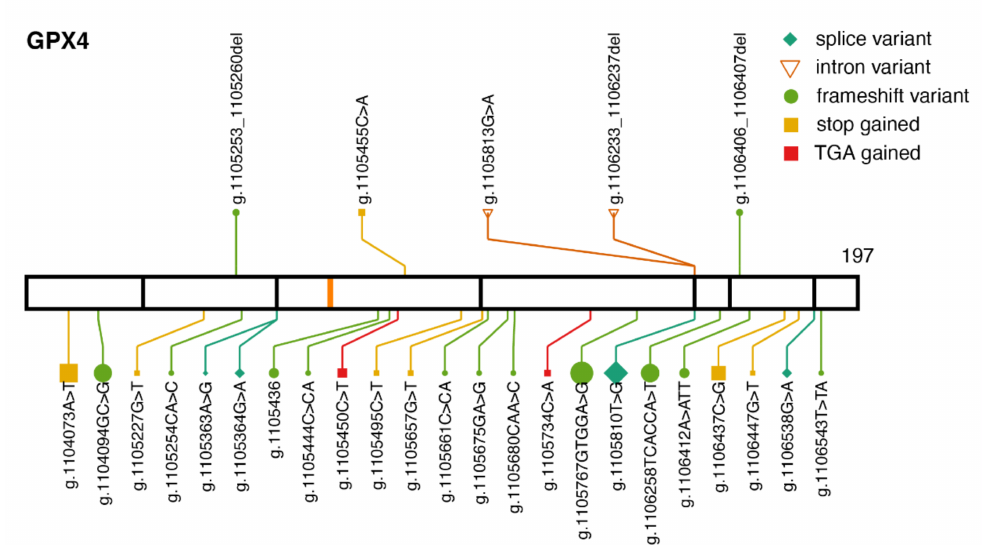
Figure 2. Pathogenic variants and protein-truncating variants in GPX4. Location of ClinVar pathogenic variants (above) and gnomAD protein-truncating variants (below), along the GPX4 protein sequence. The same aesthetics as in Figure 1b are used. GPX4 transcript: